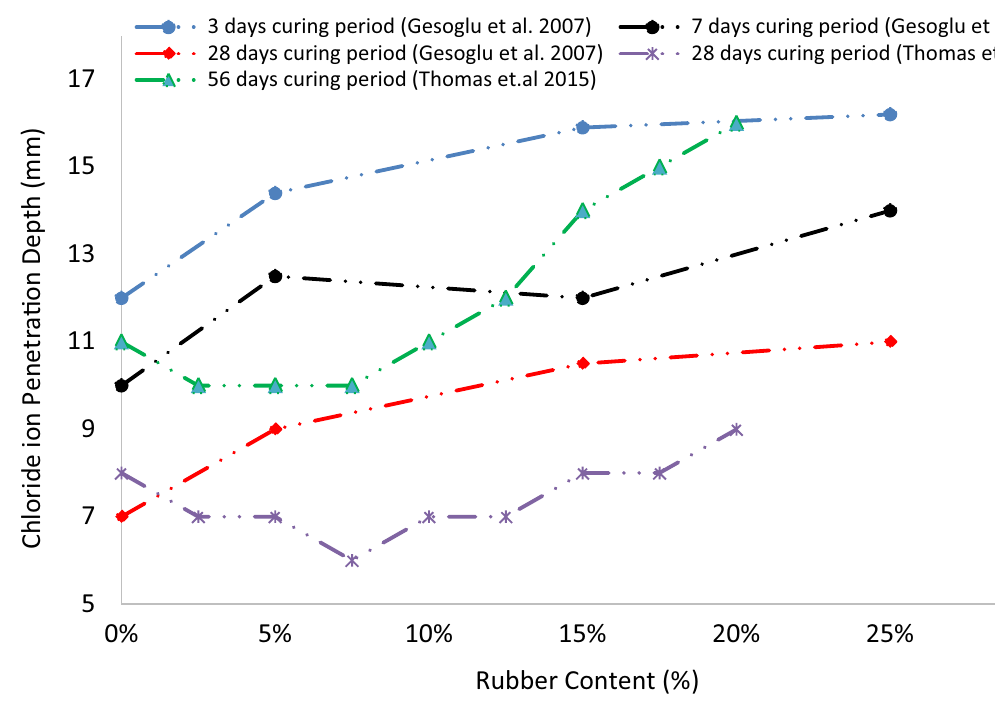
Fig. 19 Chloride ion penetration depth with CR percentage [1,